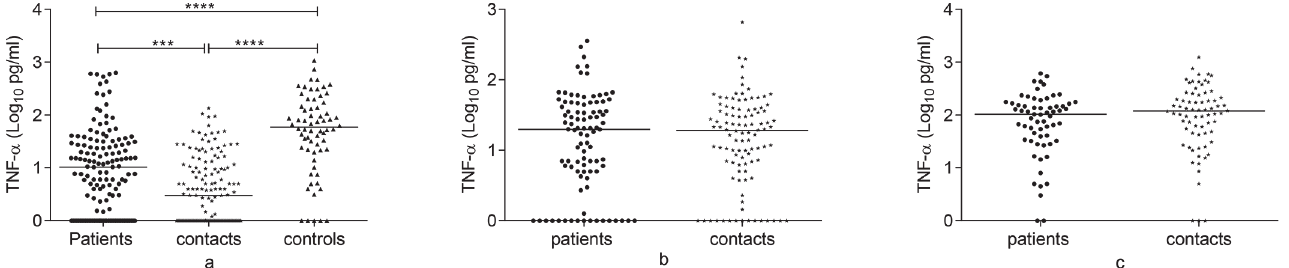
Fig 3. Comparison of TNF- α response to Rv2031 among groups at baseline, 6 and 12 months. TNF- α response at baseline (a), 6 months (b) and 12 months (c) following whole blood stimulation with Rv2031 for 48 hours. Filled circles represent patients, filled diamonds represent contacts and filled triangles represent controls. Results are individual responses and cytokine levels are expressed as log 10 pg/ml. Horizontal bars are medians. Kruskal-Wallis test with Dunn ’ s multiple comparisons (a) and Mann-Whitney test (b and c) were used to compare groups. *** p < 0.001, **** p < 0.0001.